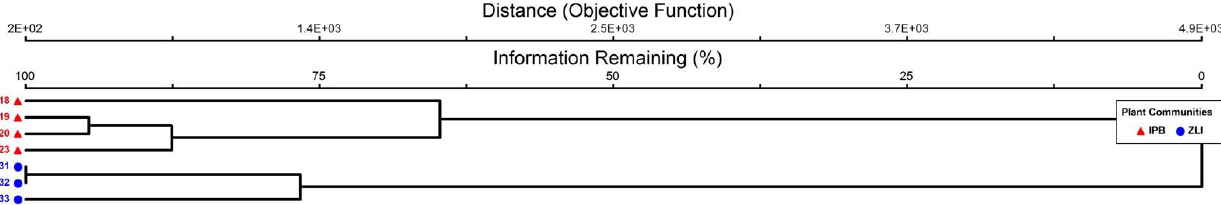
Figure 3. Cluster analysis indicating two different plant communities’ recognition based upon the grouping of seven sampling sites and 97 plant species. IPB: Indigofera-Parrotiopsis-Bistorta and ZLQ: Ziziphus-Letopus-Quercus .